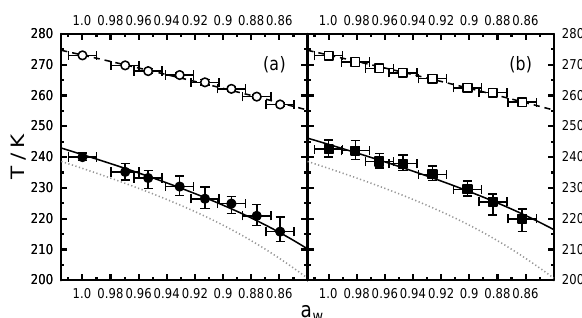
Fig. 1. Experimentally derived median freezing temperatures with 10th and 90th percentiles and mean melting temperatures with ± 1 σ of leonardite in water and aqueous ( NH 4 ) 2 SO 4 droplets (a) , and Pa- hokee peat in water and aqueous ( NH 4 ) 2 SO 4 droplets (b) are shown as a function of a w determined at particle preparation conditions. Ice melting and homogeneous freezing curves are plotted as dashed and dotted lines, respectively (Koop and Zobrist, 2009). The ho- mogeneous freezing curve represents J hom = 2 . 18 × 10 6 cm − 3 s − 1 . The solid lines are best fits based on the data in which the ice melt- ing curves are shifted by 1a w = 0 . 2703 for leonardite in (a) and by 1a w = 0 . 2466 for Pahokee peat in (b) . The derived freezing curves = ( 9 . 6 ± 2 . 5 ) × 10 4 and ( 5 . 4 ± 1 . 4 ) × 10 4 cm − 2 s − 1 represent J exp het for leonardite (a) and Pahokee peat (b) , respectively. It is assumed that a w does not change with